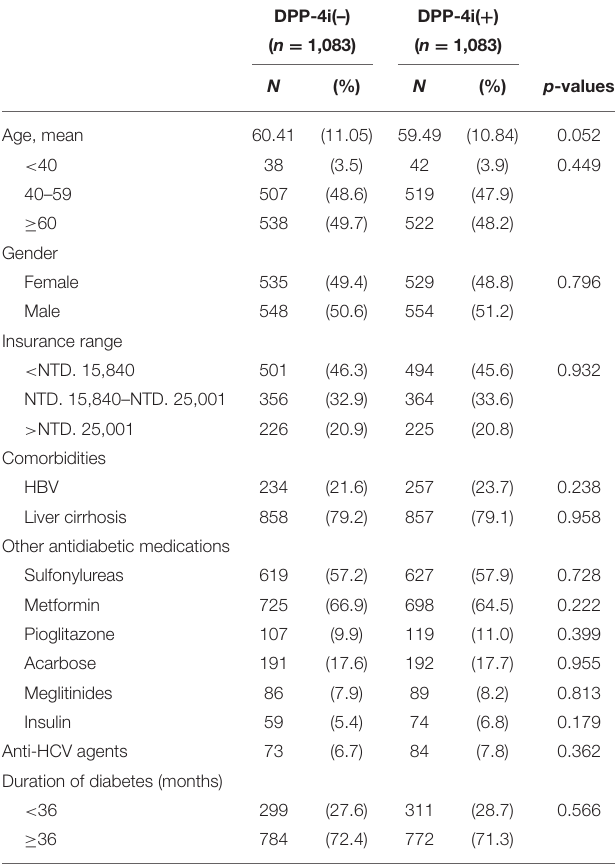
TABLE 1 | Demographic data.